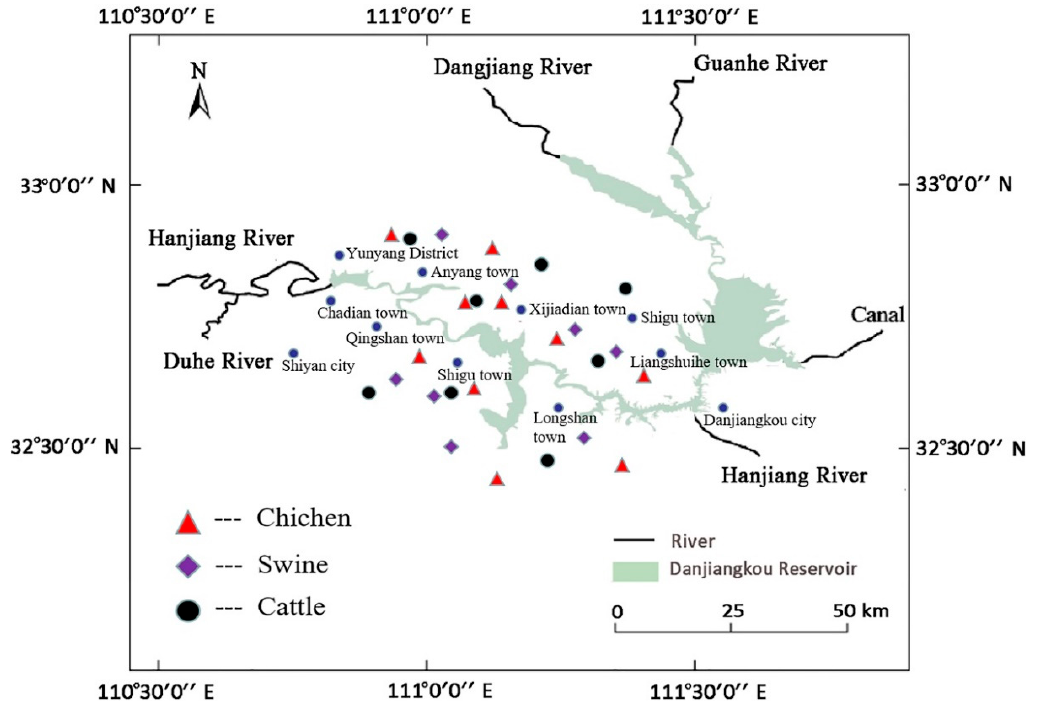
Figure 1. Distribution map of the target family farms in Danjiangkou Reservoir Basin.